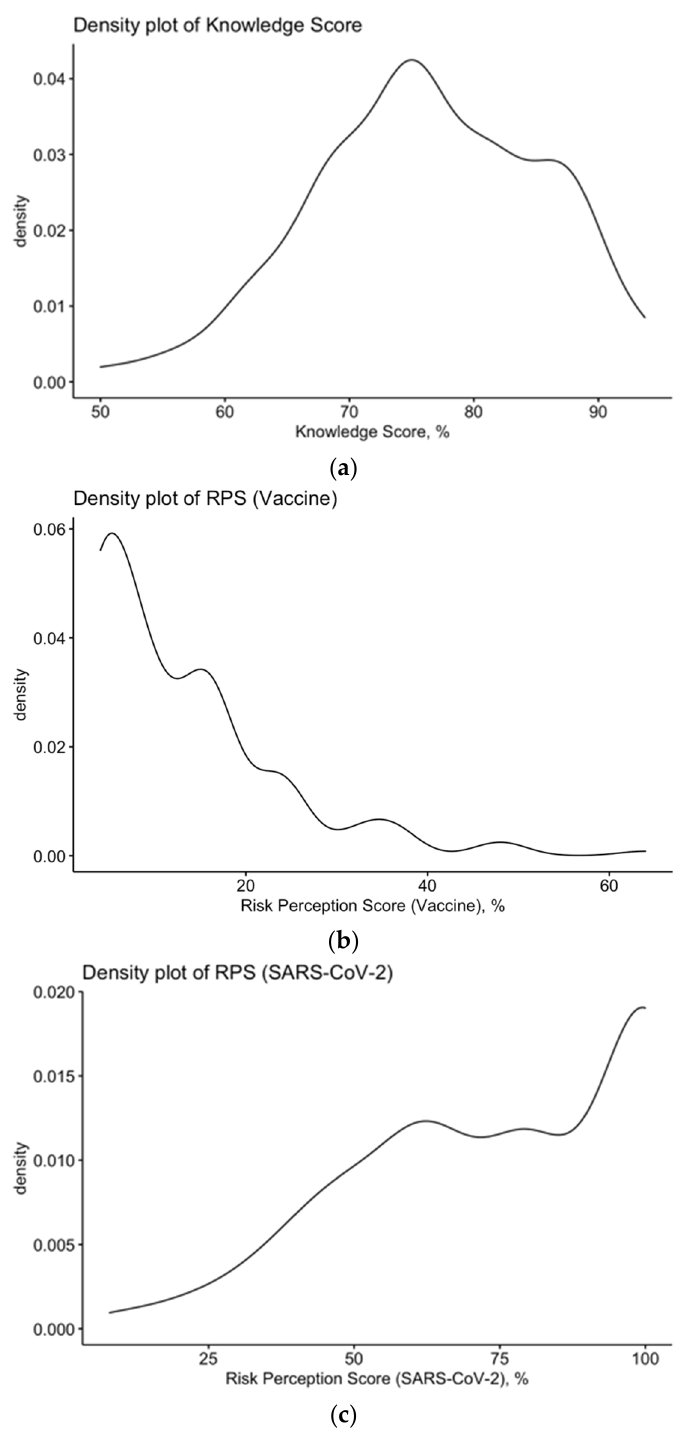
Figure 1. Density plot for (left to right): ( a ) knowledge score (%); ( b ) risk perception score (%) for mRNA vaccine; ( c ) risk perception score (%) for SARS-CoV-2. All cumulative scores appeared not-normally distributed (D’Agostino–Pearson p value < 0.001 for all scores).